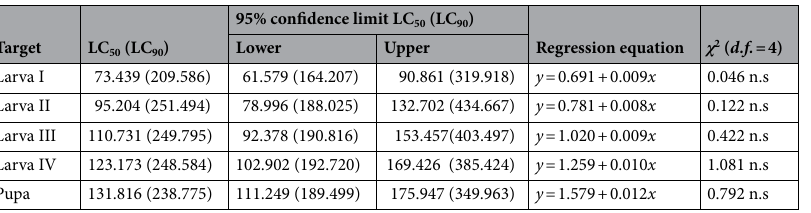
Table 1. Larval and pupal toxicity of Lawsonia inermis against malaria vector, Anopheles stephensi. No mortality was observed in the control. LC 50 = lethal concentration that kills 50% of the exposed organisms. LC 90 = lethal concentration that kills 90% of the exposed organisms. χ 2 = chi-square value. d.f. = degrees of freedom. n.s . = not significant (α =